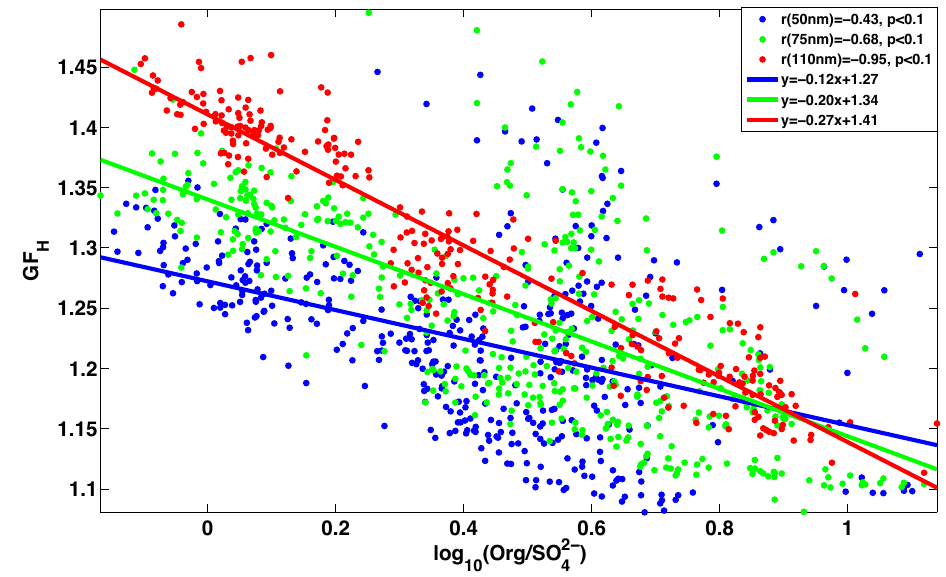
Fig. 3. Correlations between the average hygroscopic growth factor and the ratio between the concentrations of particulate organics and sulfates from AMS data for three different particle